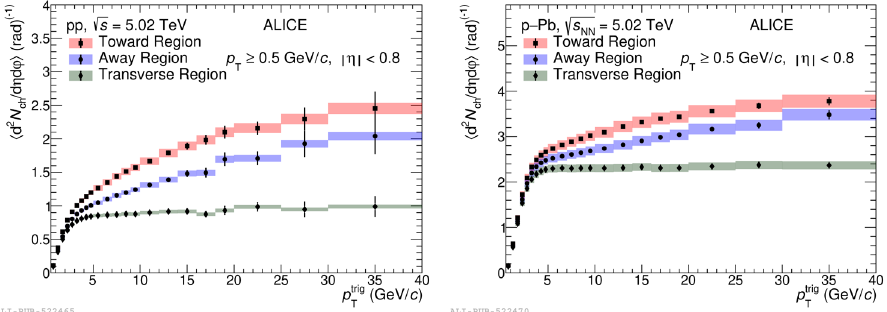
Figure 1: Multiplicity density as a function of p trig collisions at √ s NN = 5 . 02 TeV. Results for the toward, transverse, and away regions are displayed. The shaded boxes and the error bars represent the systematic and statistical uncer- tainties,